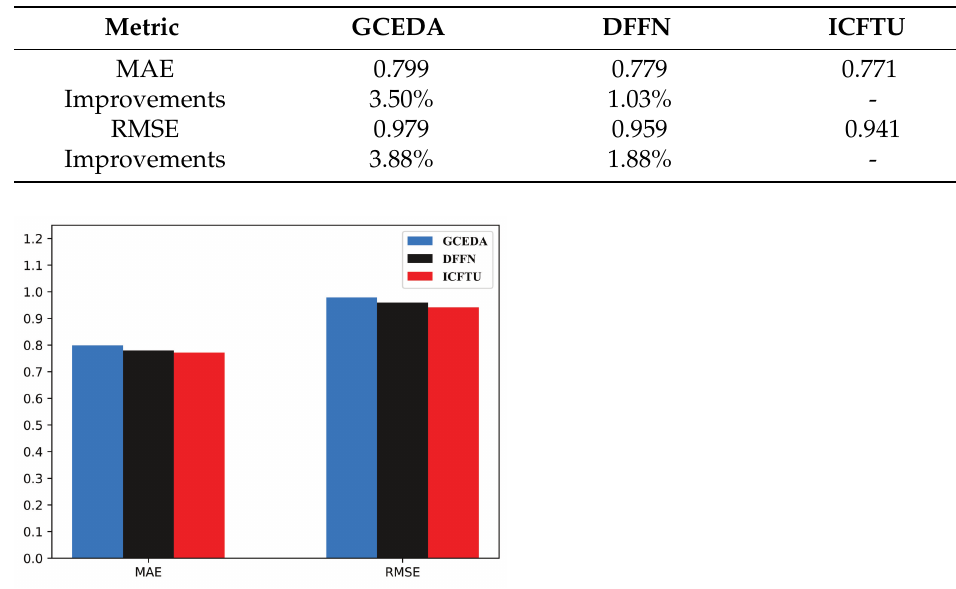
Figure 10. The results of the compared experiment with other two recommendation